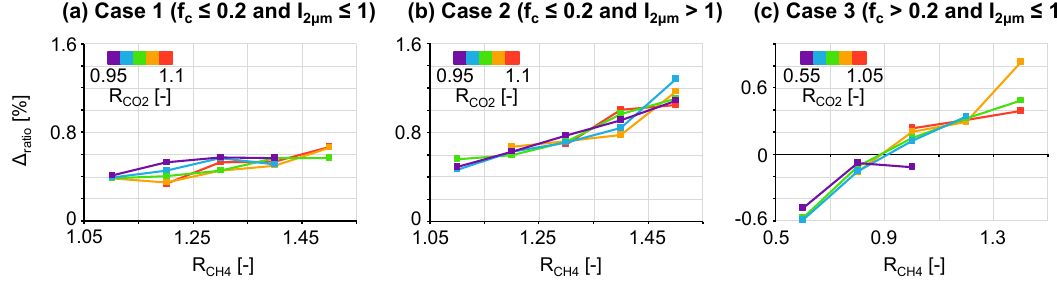
Figure 5. Variation of the relative difference in the ratio component between GOSAT and TCCON ( ∆ ratio ) according to the ratio between the partial column-averaged dry-air mole fractions for the lower atmosphere and that for the upper atmosphere (R CH4 and R CO2 ): ( a ) Case 1 (the cloud fraction (f c ) ≤ 0.2 and the normalized 2 μ m band radiance (I 2 μ m ) ≤ 1); ( b ) Case 2 (f c ≤ 0.2 and I 2 μ m > 1); ( c ) Case 3 (f c > 0.2 and I 2 μ m ≤ 1).